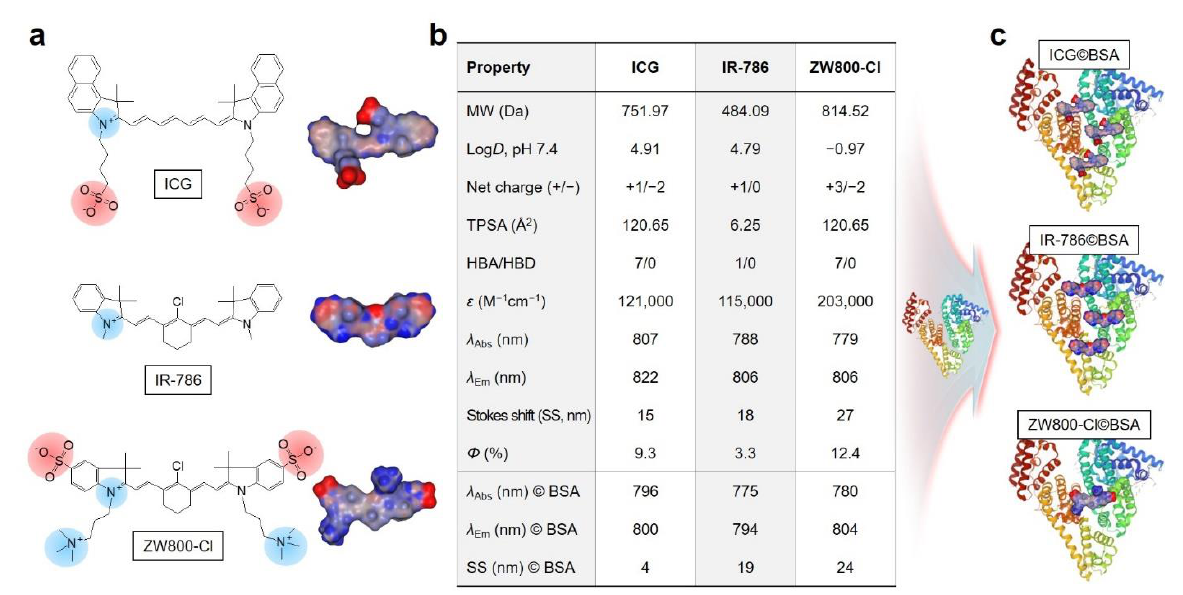
Figure 1. ( a ) Chemical structure, net surface charge, and three-dimensional (3D) modeling of the geometrical positions of ICG, IR-786, and ZW800-Cl NIR dyes. Red, negative charge; blue, positive charge; gray, hydrophobicity. ( b ) Physicochemical and optical properties of ICG, IR-786, ZW800-Cl in 100% serum, and their complexes with BSA in PBS at pH 7.4. In silico calculations of the distribu- tion coefficient (log D at pH 7.4), topological polar surface area (TPSA), and hydrogen bond accep- tors/donors (HBA/HBD) were performed using Marvin and JChem calculator plugins (ChemAxon). ( c ) Simplified schematic for the formation of each dye©BSA complex.